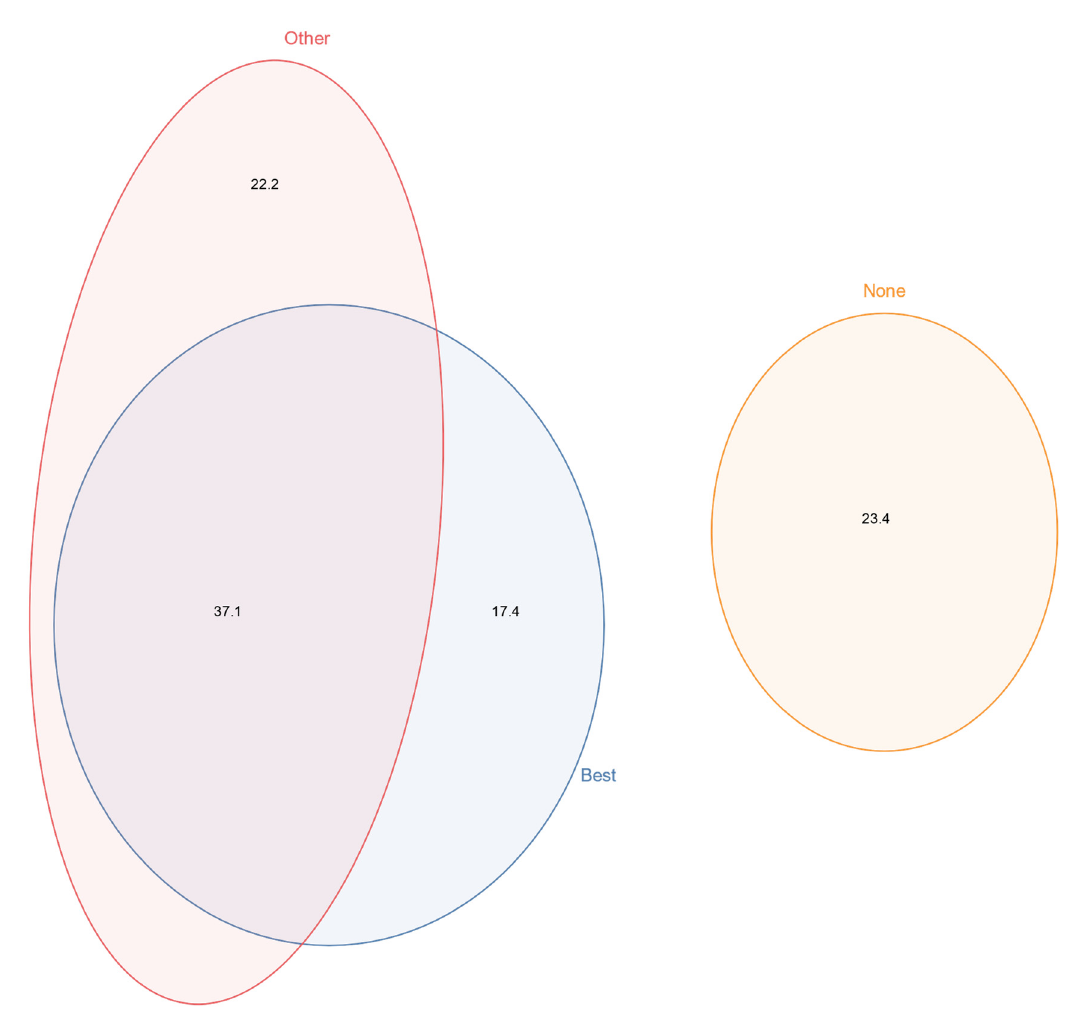
Figure 3. Euler plot showing the percentage of the three categories of varroa monitoring methods that beekeepers reported to have used in winter 2021. Best: alcohol wash, sugar shake, CO 2 injection, and sending samples to a lab. Other: includes any other method. None: defined as no monitoring, or if a beekeeper cited “visual inspection of adult bees” as a method for